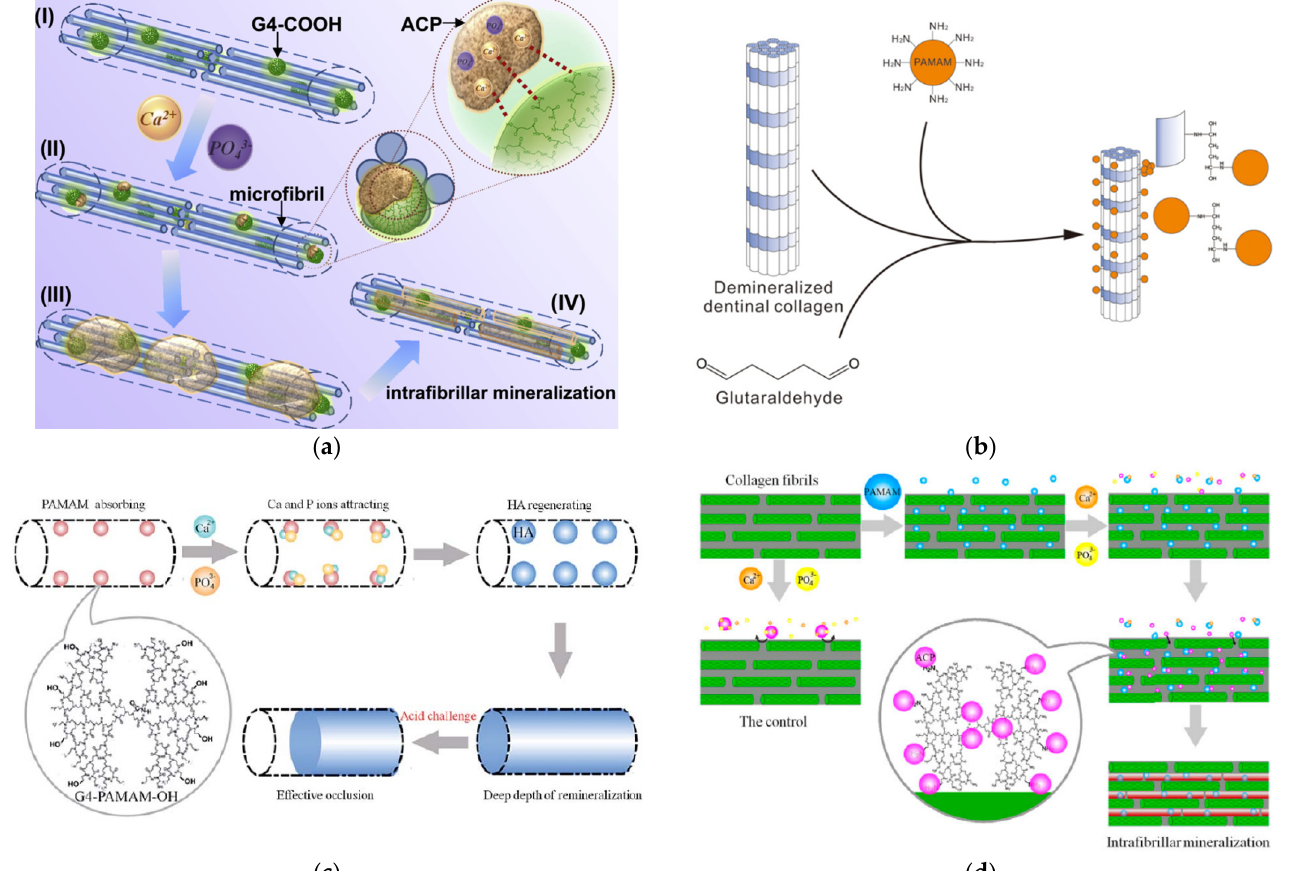
Figure 21. ( a ) Schematic illustration of the bioinspired intrafibrillar mineralization process induced by G4-COOH as artificial proteins. ( I ) G4 PAMAM-COOH binds to collagen fibrils at specific sites of the collagen assembly and retains in it relying on electrostatic force and size exclusion effect. ( II ) G4 PAMAM-COOH captures and stabilizes the metastable amorphous calcium phosphate (ACP) nano-precursors by its carboxyl groups in the mineralization medium. ( III ) G4 PAMAM-COOH acts as the template to make ACP nano-precursors arrange in an ordered manner, resulting in the periodicity of the mineralized fibrils. ( IV ) Small mesocrystals are guided to assembly into larger ones by the immobilized G4 PAMAM-COOH and transformed into apatite nanocrystals, thus the intrafibrillar mineralization along the microfibrils within the collagen matrix is achieved Reproduced with permission from [210]. Copyright: Elsevier Ltd.; ( b ) Reaction scheme that reveals the process of PAMAM dendrimers crosslinking to demineralized dentinal collagen by using glutaraldehyde. Published under Creative Commons license from [213]. ( c ) Schematic demonstration of the effective dentinal tubule occlusion induced by G4-PAMAM-OH. Reproduced with permission from [217]. Copyright: RSC Publishing. ( d ) Schematic demonstration of the mechanism of biomimetic miner- alization of collagen fibrils induced by G3-PAMAM. The rectangle represents a collagen fibril. The green cylinders within the rectangle represent microfibrils. The orange, yellow, and purple balls represent Ca 2+ ions, PO 43 − ions, and ACP nanoparticles. Under permission from [219]. Copyright: Taylor &